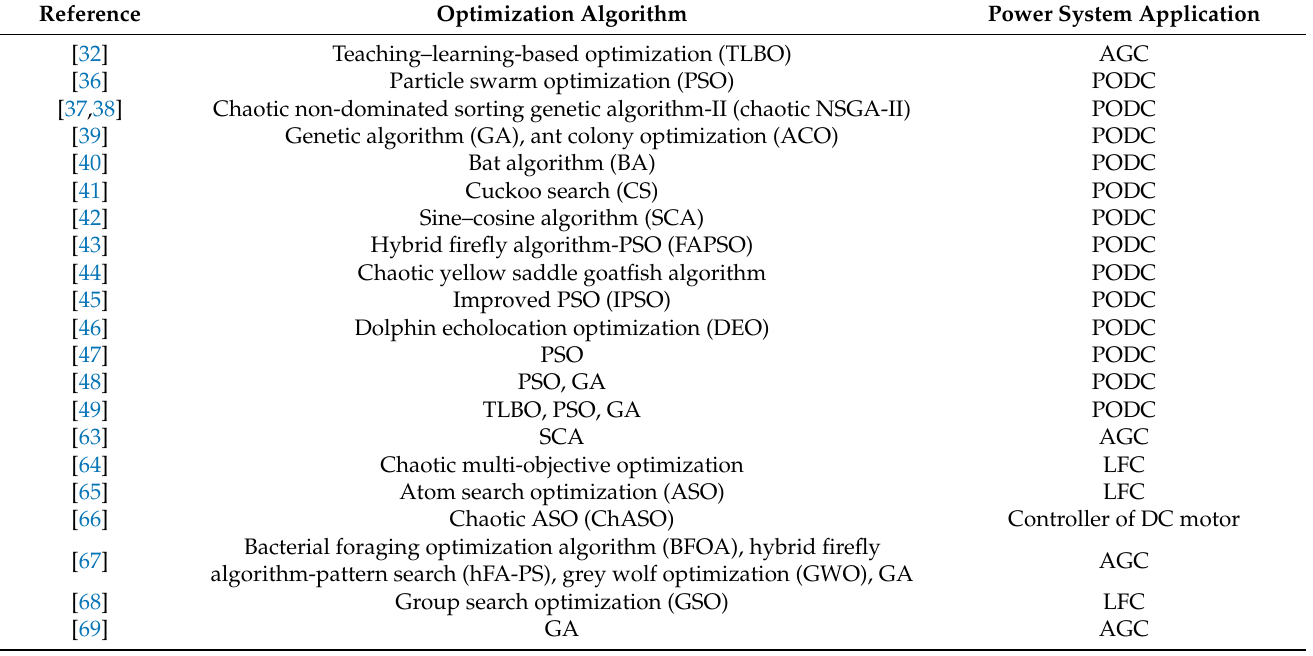
algorithm-pattern search (hFA-PS), grey wolf optimization (GWO),